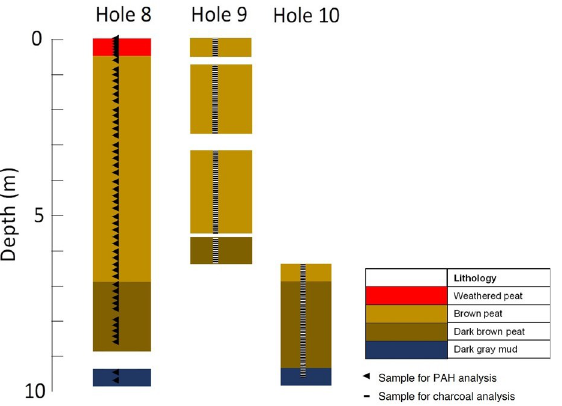
Fig 2. The lithology of Borneo peat core with a total length of 10 m. The selected intervals for analysis are indicated by black triangles ( ◄ ), and charcoals were measured in every 2 cm-interval, indicated by dash lines (-). The difference between brown and dark brown colours is gradual and not